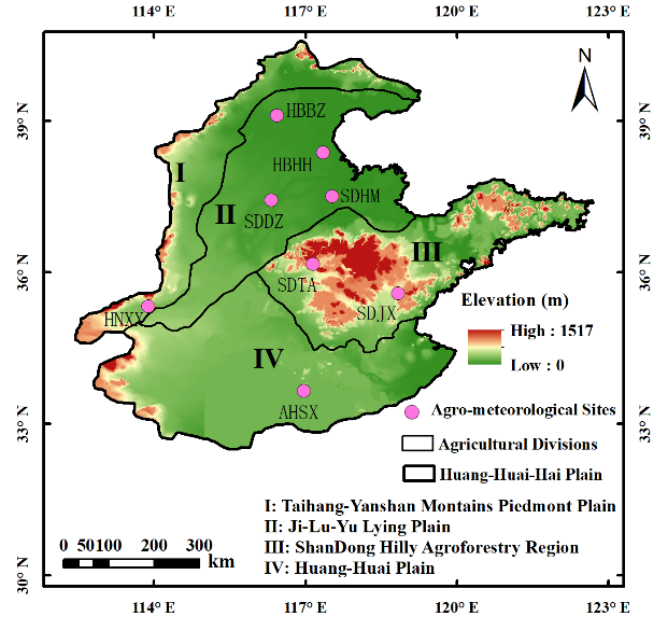
Figure 1. Study area and distribution of agro-meteorological sites.